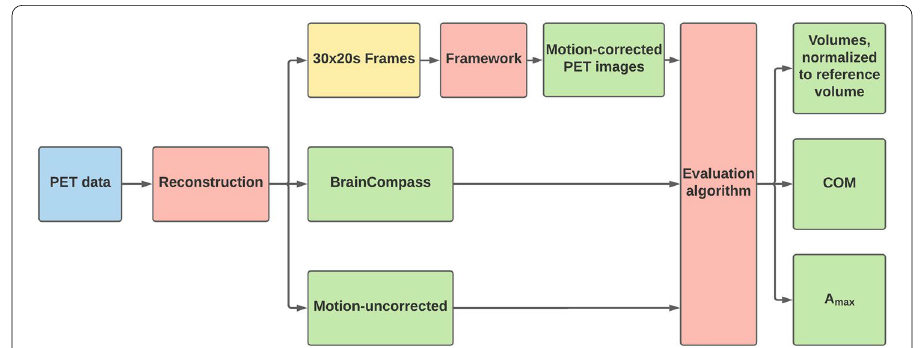
Fig. 6 Schematic representation of the evaluation method. After reconstruction, three or four datasets were available: motion-uncorrected, BrainCompass and MCFLIRT (30 × 20s and if relevant motion-adapted). To obtain MCFLIRT corrected images, the frameworks of Figs. 4 and 5 had to be